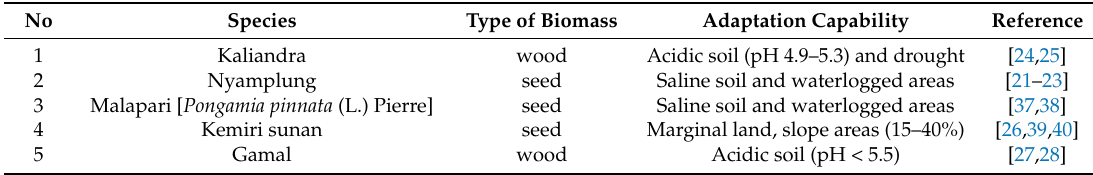
Table 1. Review of adaptability of selected bioenergy crops to different type of soils.